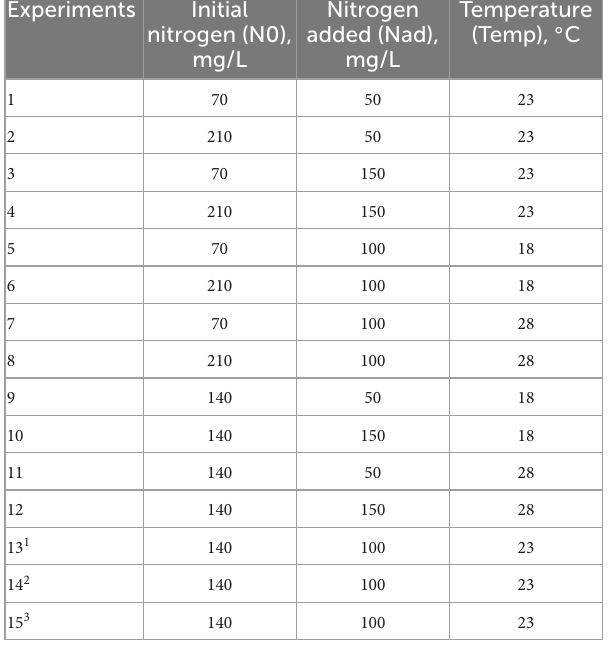
TABLE 1 Experimental conditions for the 15 fermentations.